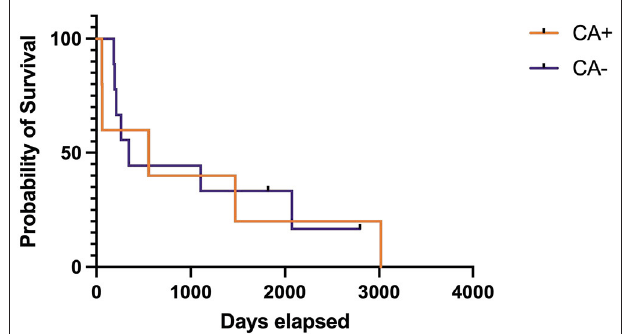
FIGURE 1 | Kaplan-Meier survival care of deceased dogs with meningoencephalomyelitis of unknown origin treated with cyclosporine and prednisone with (CA + ) or without (CA–) an initial dose of cytarabine (CA). Deaths not directly related to MUO or treatment of MUO have been censored and are noted by a vertical tick